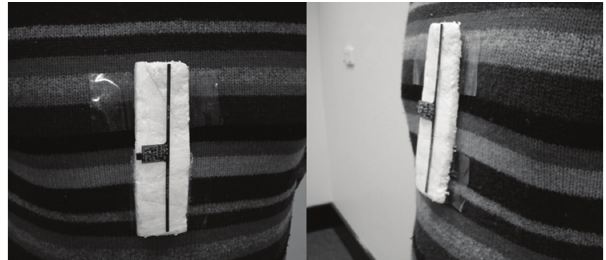
Figure 22: Dipole antenna worn on human body. The thickness of the polystyrene is about 10mm, which leaves enough space from human body to the WISP tag.